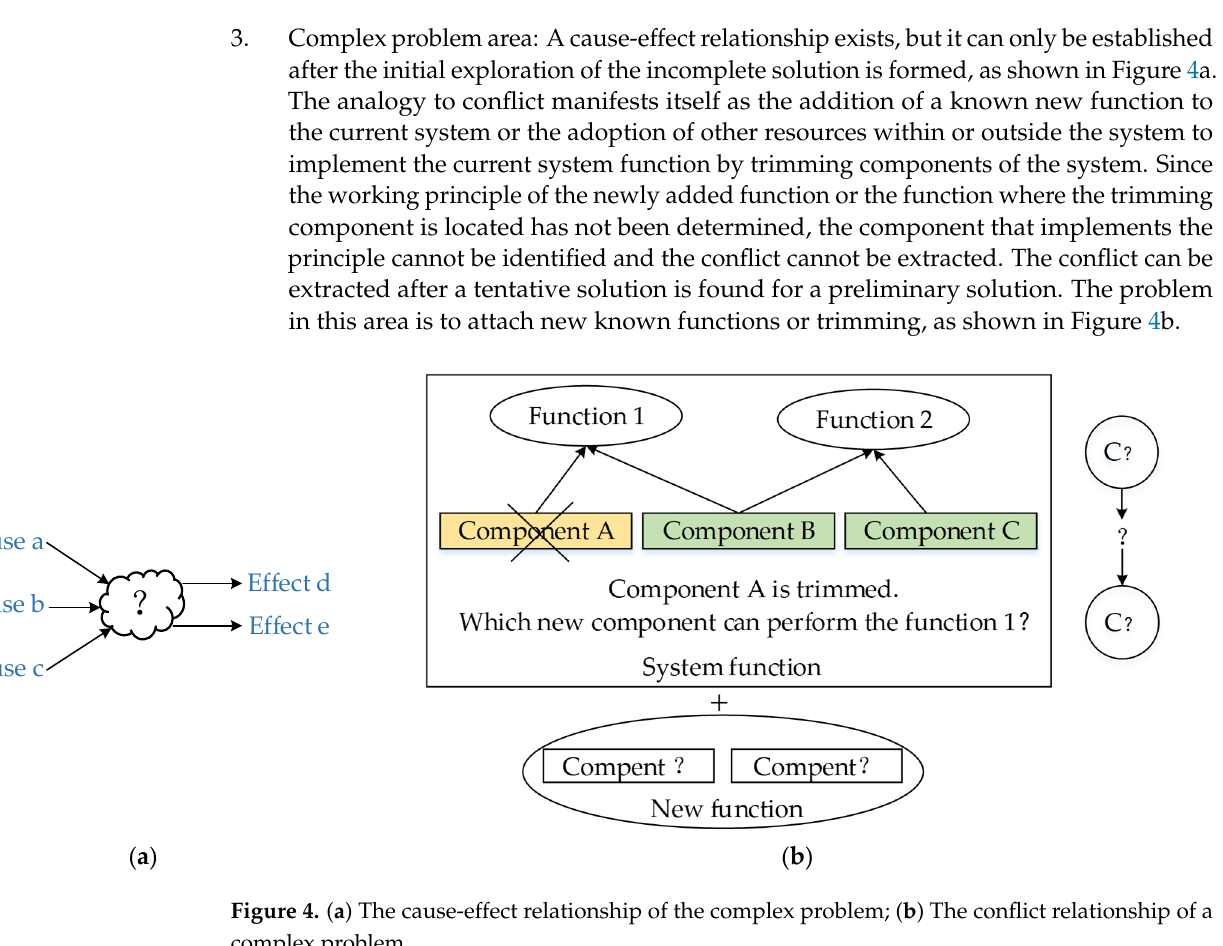
Figure 3. ( a ) The cause-effect relationship of the complicated problem; ( b ) The conflict relationship of the complicated problem.